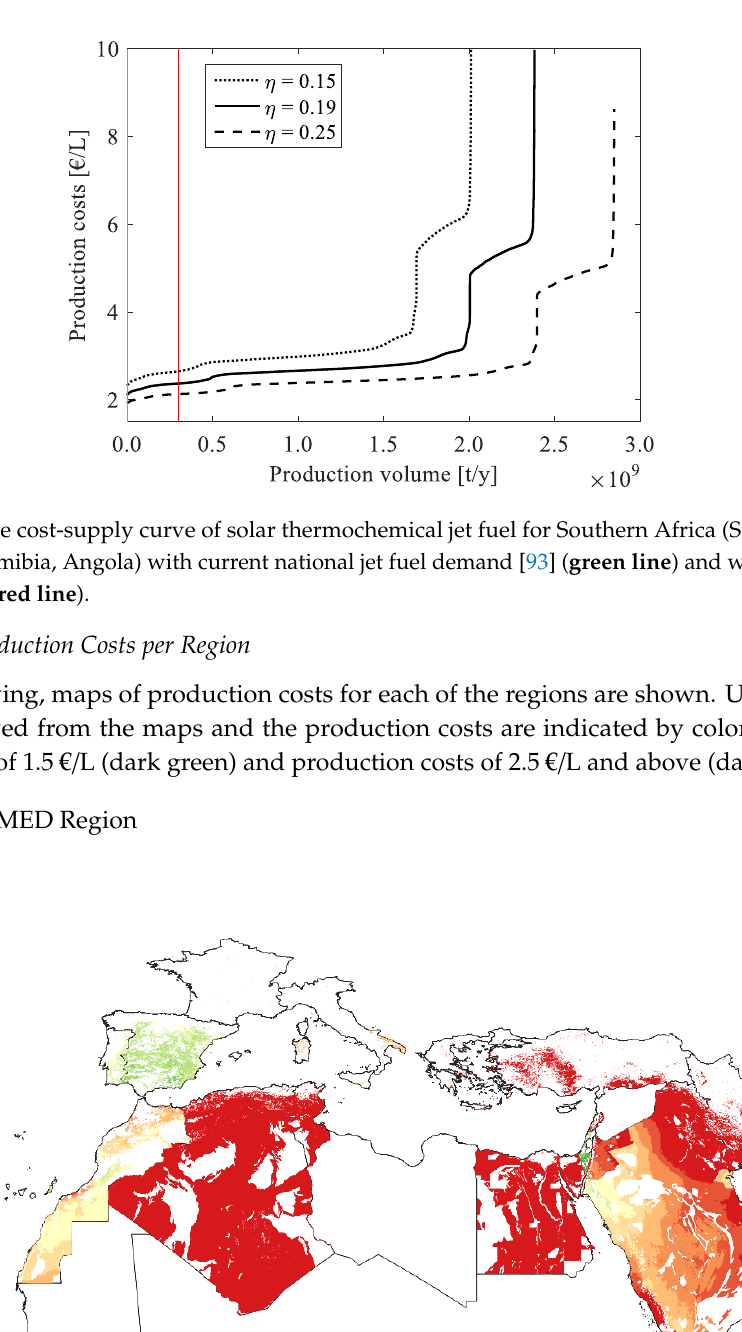
Figure A4. The cost-supply curve of solar thermochemical jet fuel for South America (Chile, Bolivia, Peru, Argentina) with current national jet fuel demand [94] ( green line ) and world jet fuel demand [92] ( red line ).